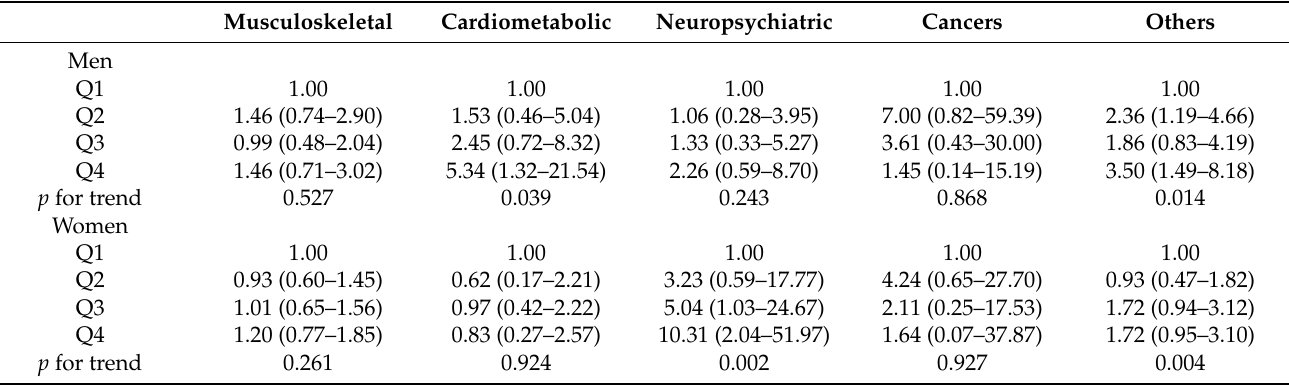
Table 4. Multiple regression analysis * between hand grip strength † and each etiology of functional disability according to